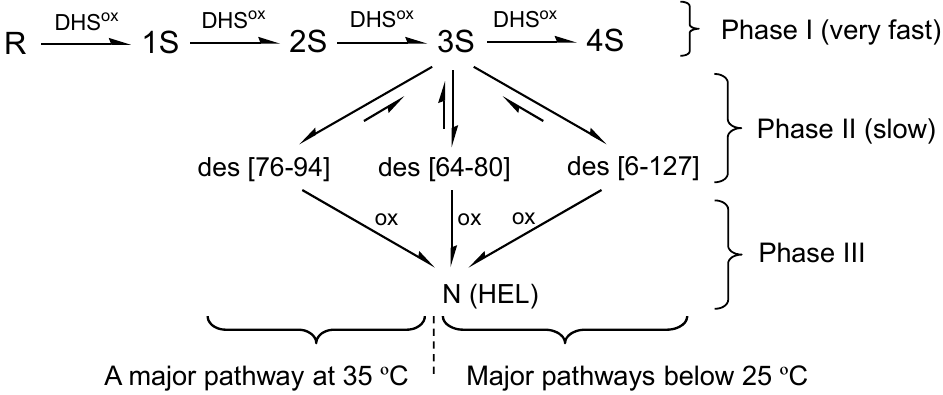
Figure 10. The oxidative folding pathways of HEL characterized by using DHS ox at pH 8.0 in the presence of 2 M